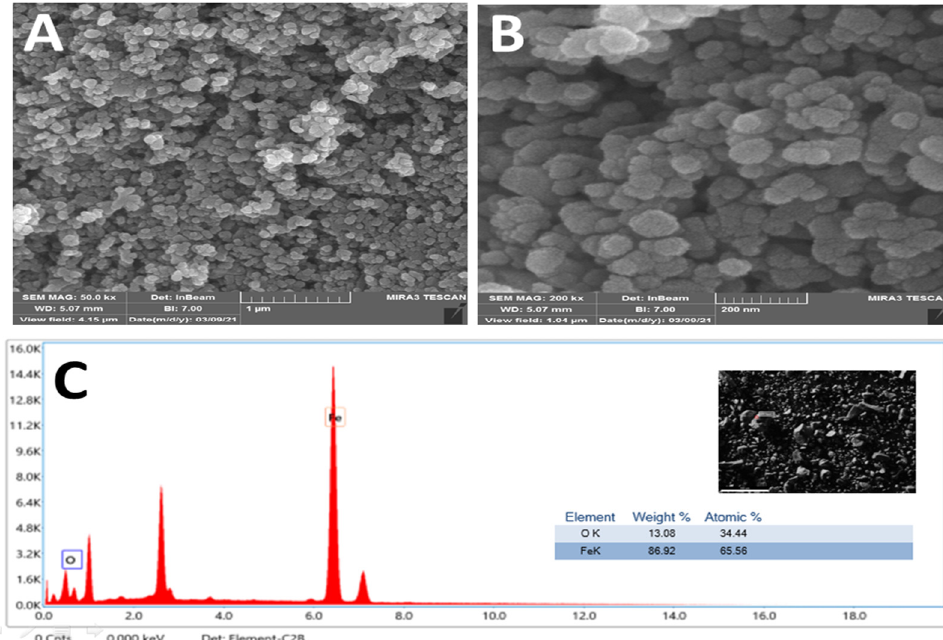
Figure 9. ( A,B ) Average particle size of prepared SRLe - α Fe 2 O 3 NPs measured using SEM (scale bar = 500 nm in ( A ) and 200 nm in ( B )). ( C ) EDX profile .